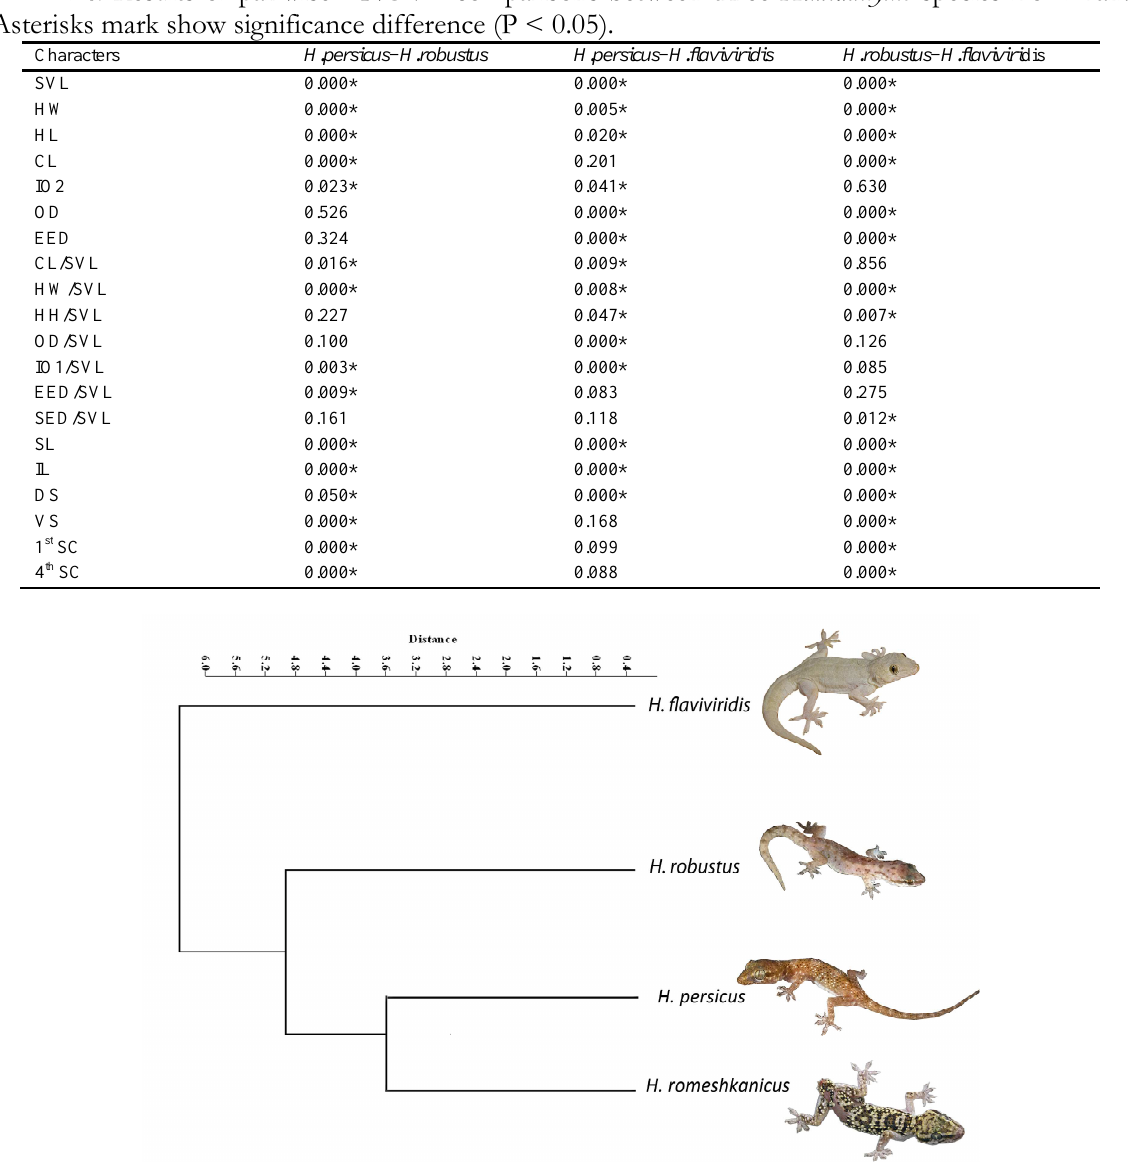
F IGURE 4. Dendrogram resulting from cluster analysis of the four studied species of Hemidactylus based on